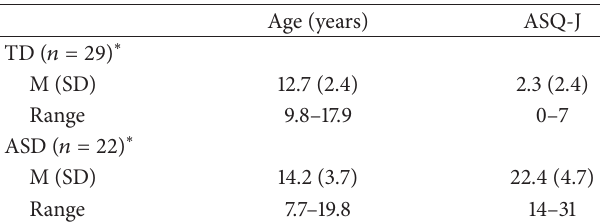
Table 2: Mean, standard deviation (SD) and range of chronological age, and scores on the Japanese version of the Autism Screening Questionnaire (ASQ-J) of participants in Experiment 2.